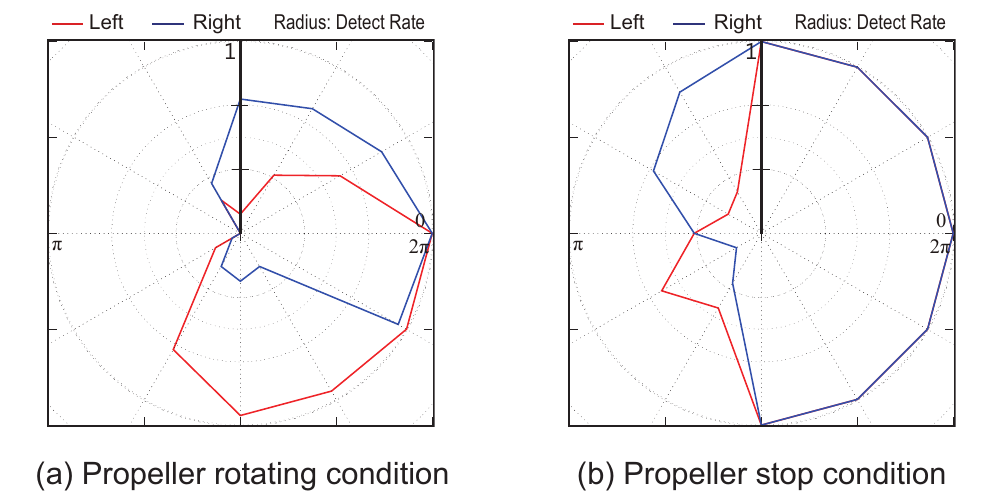
Figure 11. Detection rate results of left and right alcohol sensors at the wind speed of 0.5 m/s. Subfigure ( a ) shows the state in which the propellers of the quadcopter rotate; subfigure ( b ) shows the result for the propellers of the quadcopter